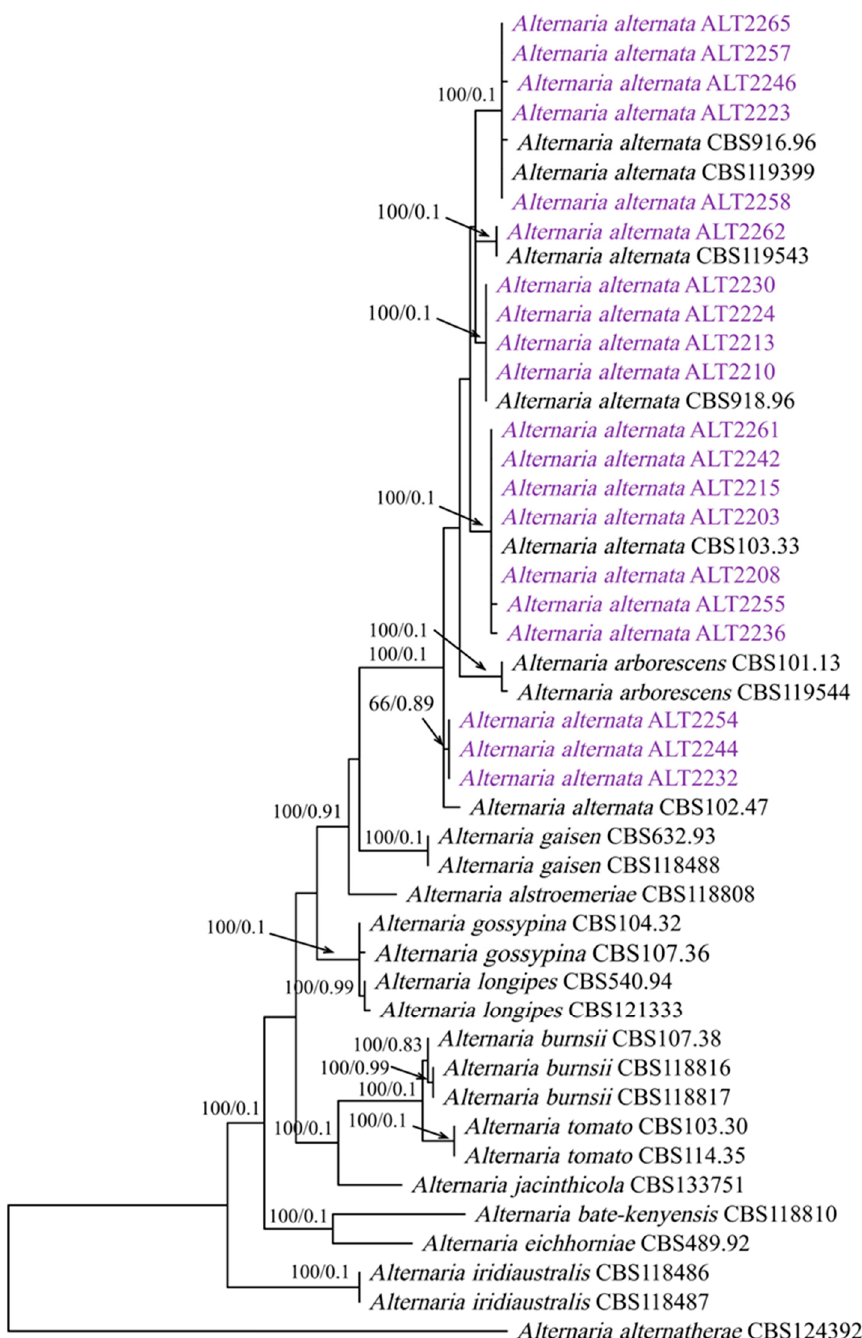
Figure 1. Phylogenetic tree generated by the MP-based analysis of the combined Alt-a1 , gapdh , and rpb2 DNA sequence dataset. Branches are shown on nodes with bootstrap values (BS %) and Bayesian posterior probabilities (PP). The tree is rooted to Alternaria alternantherae CBS 124392.